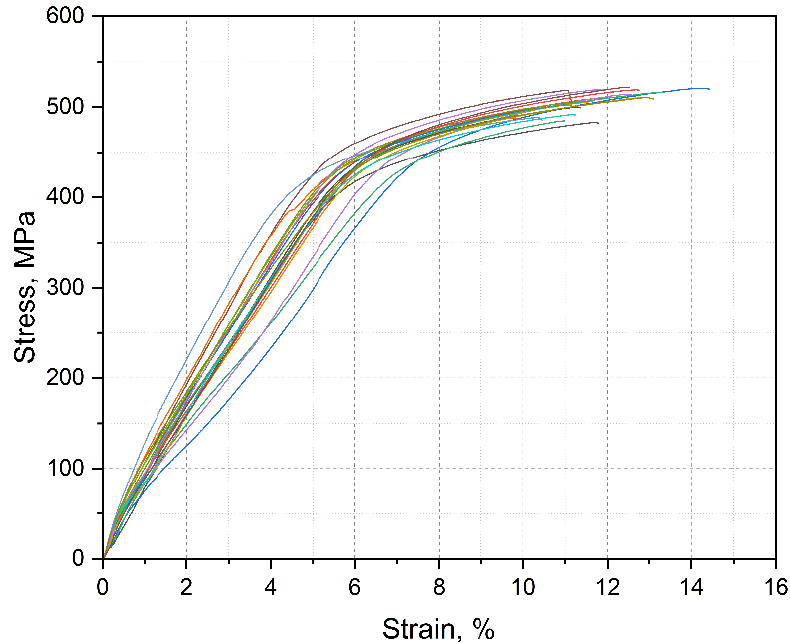
Figure 7. Stress–strain diagram of the examined specimens.